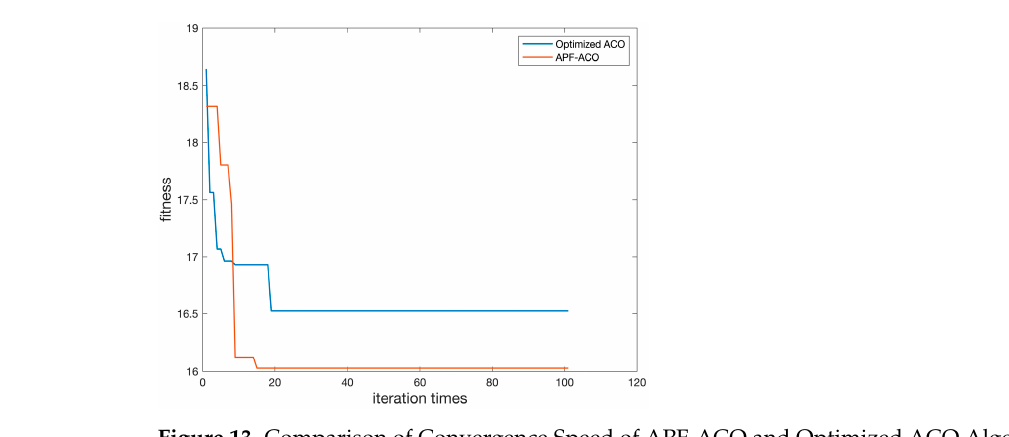
Figure 14. Visualization of path optimization results.